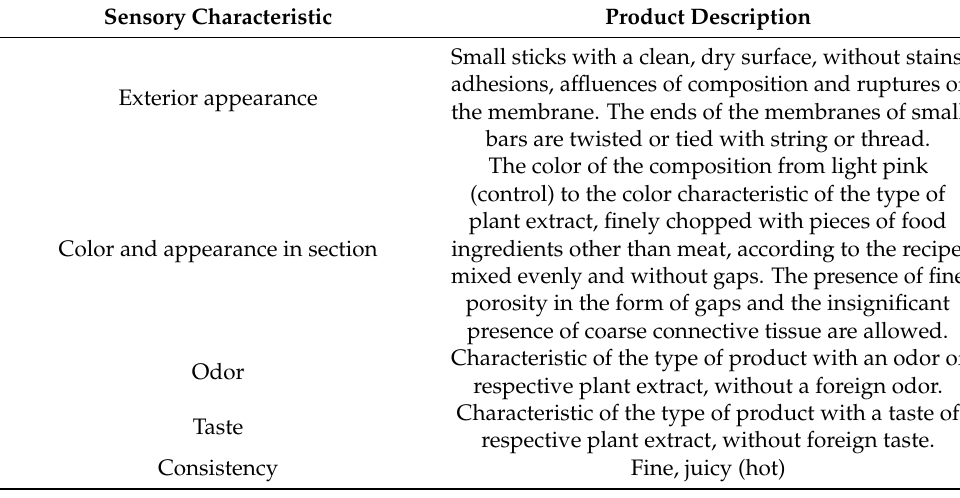
Table 5. The sensory characteristics for the evaluation of